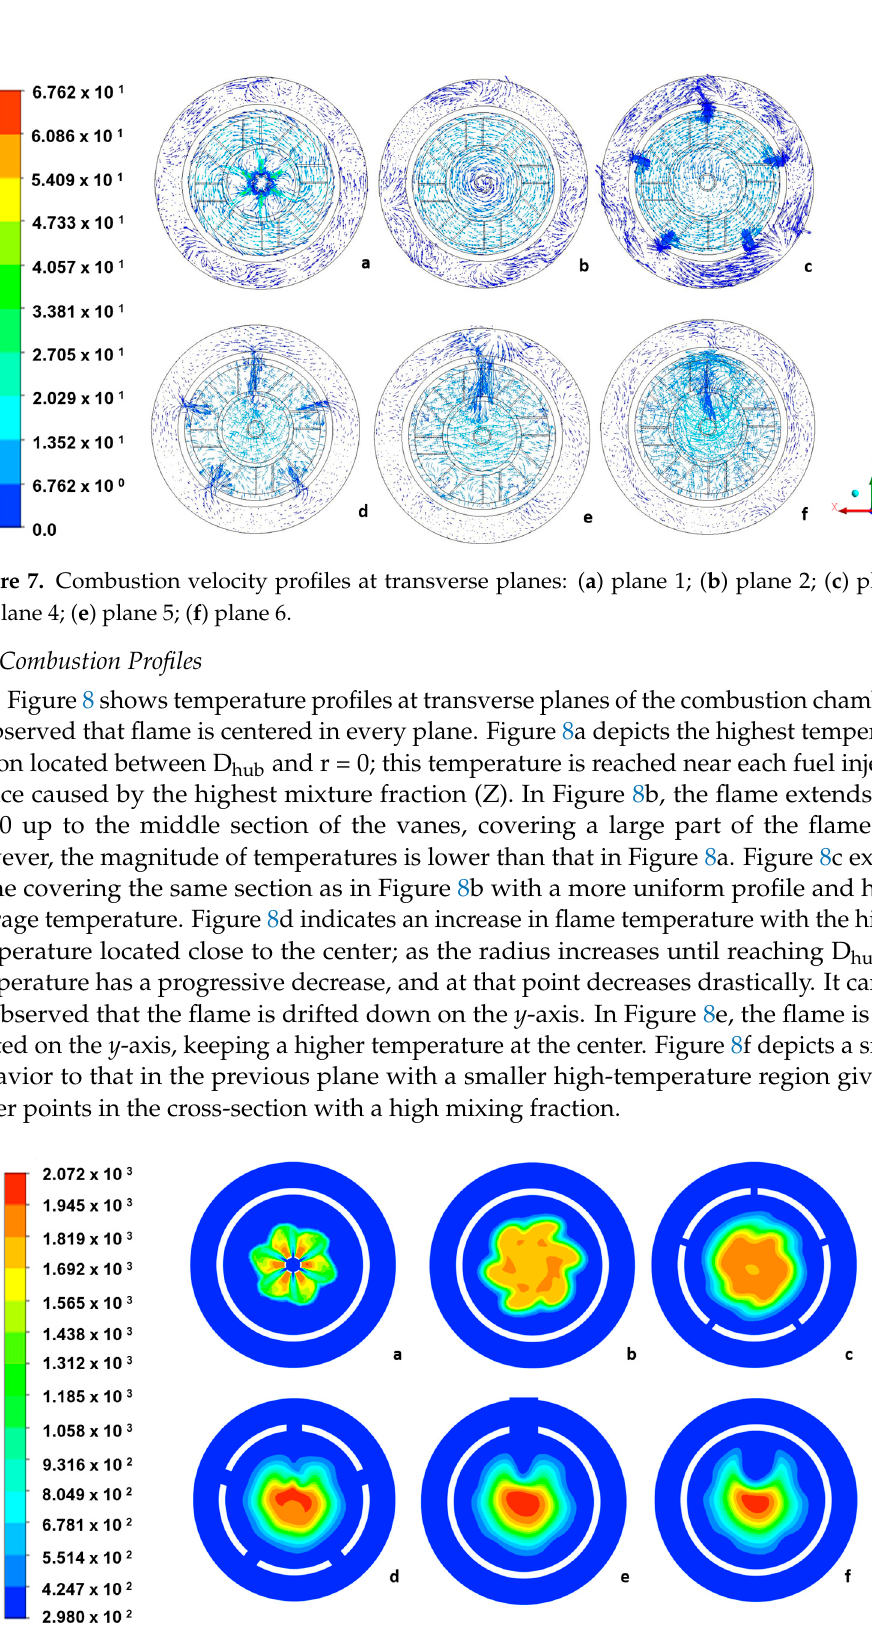
Figure 9. Temperature profile at longitudinal plane at the center of the combustion chamber. In Figure 10, mole fraction profiles of CO are shown for cross-sectional planes. Figure 10a shows a flower-shaped mole fraction profile of CO, which is mainly concentrated at the region between D hub and r = 0 caused by swirl in velocity vectors; the highest local mole fraction is 3.48 × 10 − 2 . In Figure 10b, the mole fraction increases to 7.83 × 10 − 2 , and a deformed flower-shaped profile is preserved. In this plane, the highest mole fraction is located at r = 0. Figure 10c–f shows the mole fraction of CO decreasing progressively, which indicates that there is a high conversion of reactants because there is a match be- tween temperature and CO generation. This effect occurs when there is enough energy and retention time resulting in a high conversion of CO to CO 2 .